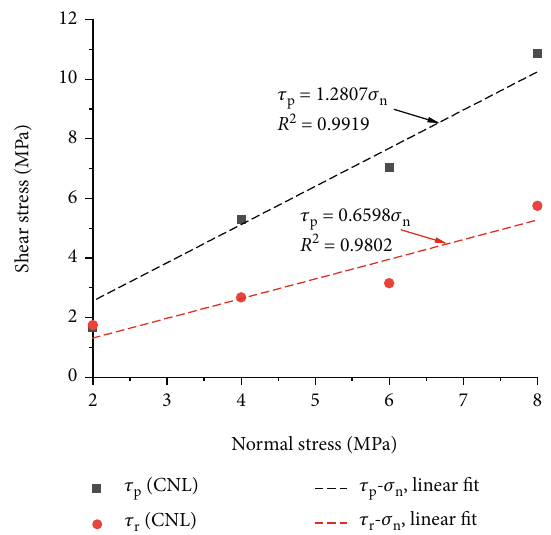
Figure 7: Variation of peak and residual shear stress with normal stress (CNL).